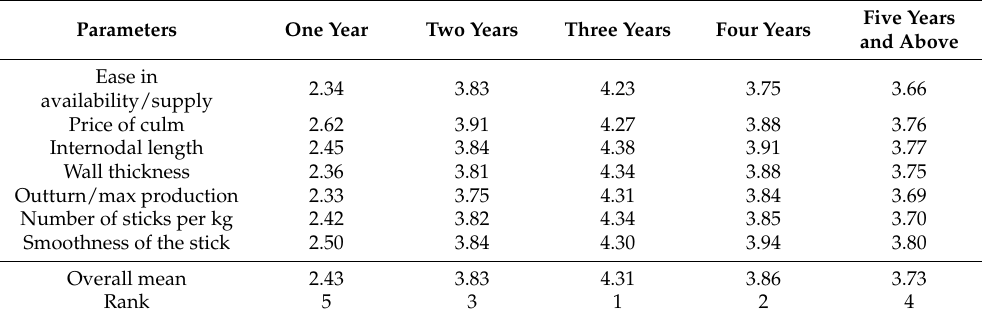
Table 2. Scores and ranking of preferential attributes from questionnaire survey for choice of age of culm used in incense stick industry.